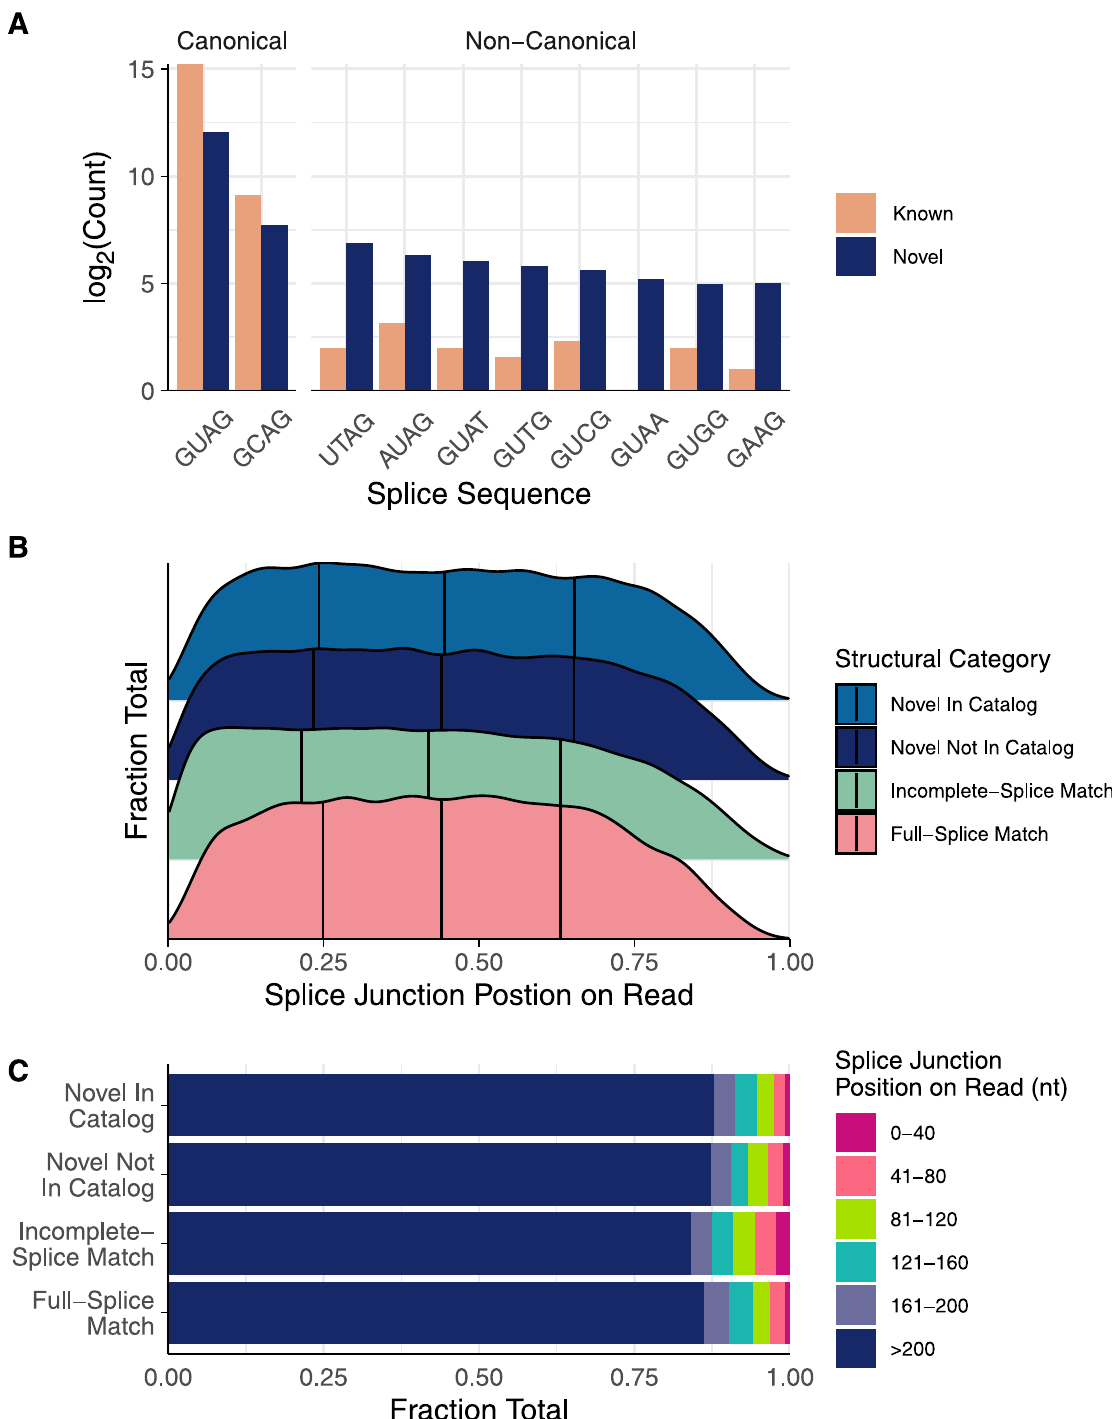
Fig 4. Iso-Seq adds to the catalog of splice junctions and identifies unannotated isoforms. (A) The 10 most abundant splice junctions in B . malayi . Most splice junctions mapped by reads were either the canonical G[UC]-AG, but a large portion of novel splice junctions identified were non-canonical, indicating the utility of Iso-Seq for identifying non-canonical junctions. (B and C) Transcripts typically contain splice junctions equally within the middle 50% of the transcript, while junctions in the first 10% and last 25% are rarer. Incomplete- splice match (ISM) reads contain a higher proportion of splice junctions at the 5’ end of the read when compared to full-splice matches, novel in catalog (NIC) reads, and novel not in catalog (NNC) reads. This suggests that ISMs represent degraded mRNA, while NIC and NNC reads likely represent true novel isoforms or transcripts with corrected splice sites.